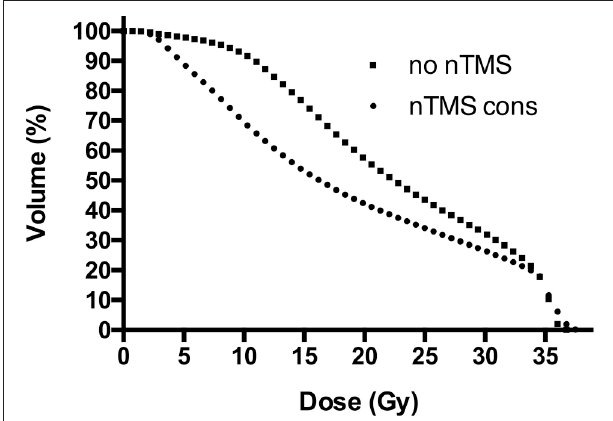
FIGURE 5 | Dose-volume histograms (DVHs) for motor maps. This figure shows the proportional volume of motor maps by navigated transcranial magnetic stimulation (nTMS) receiving a specific dose, represented by DVHs. Radiotherapy (RT) plans with constraint to the nTMS motor maps (“nTMS cons”) reduced nTMS motor map volumes receiving doses > 2Gy, as represented by a steeper gradient of DHV curves compared to conventional RT plans not taking nTMS motor maps into consideration (“no nTMS”). The most optimal effect can be observed in a dose range from 5 to 25Gy. The effect is ceasing for higher doses due to partially high overlap of the planning target volume (PTV) and nTMS motor